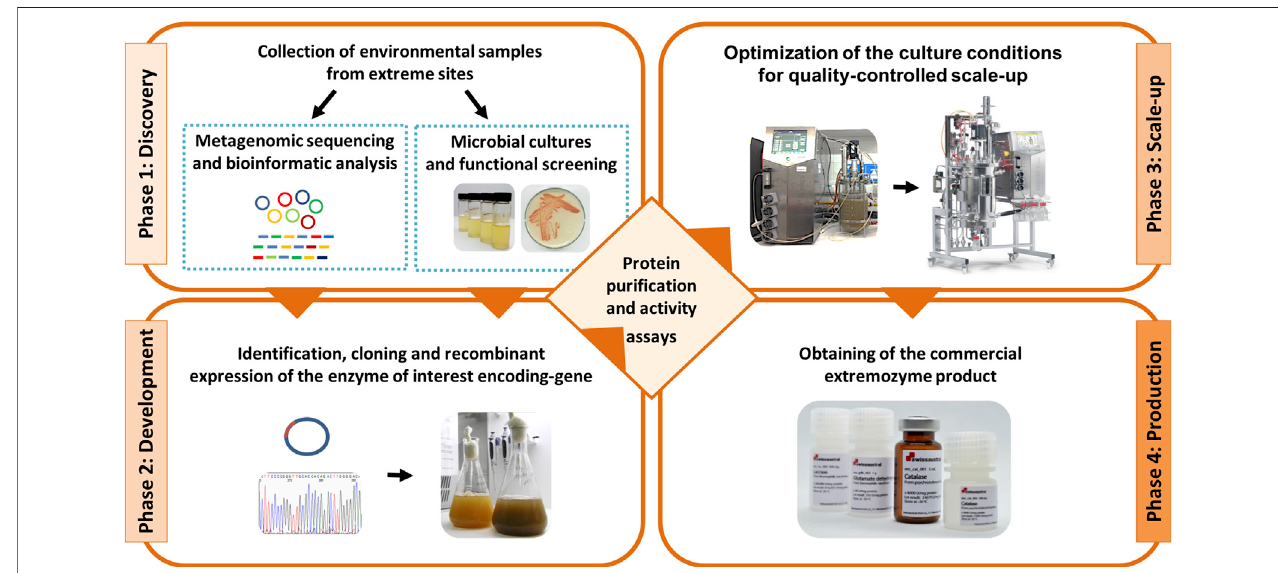
FIGURE1| Strategyforthescreeningand production ofnewextreme biocatalysts fromenvironmental samples.Culture dependent and independent approaches to discover novel extremozymes are depicted in the discovery phase.